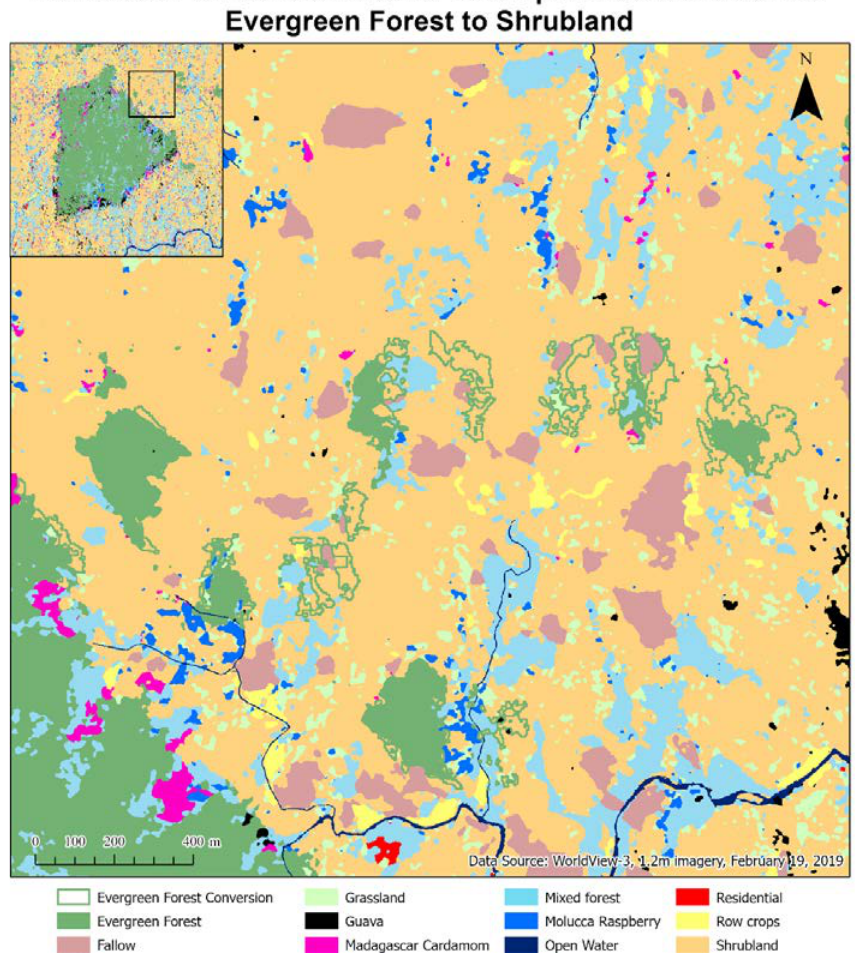
Figure 13. Evergreen Forest areas in 2010 (green boundary polygons) that were converted to Shrub- land in 2019 located east of the BNR, overlaid over the 2019 classification map. The inset map shows the 2019 classification map.